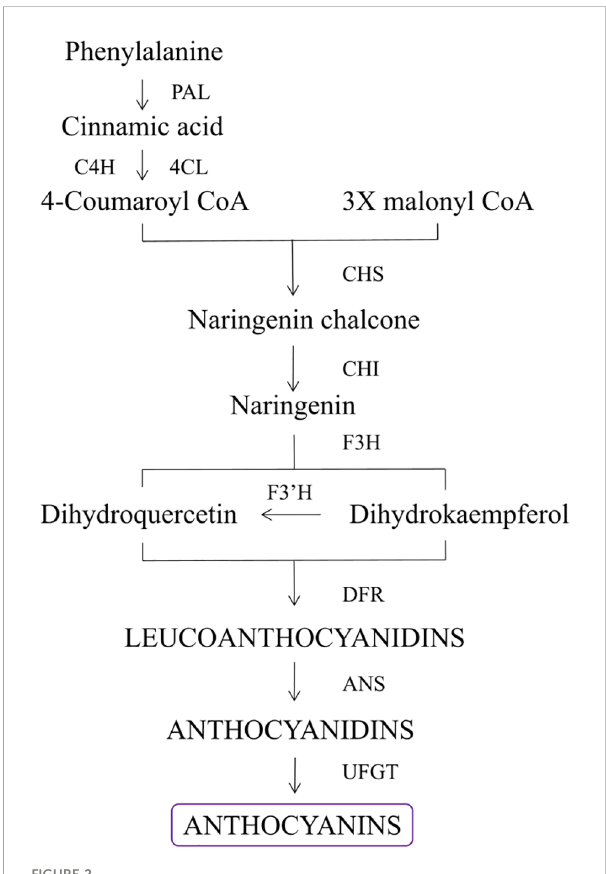
FIGURE 2 Synthetic pathway of simpli fi ed version of